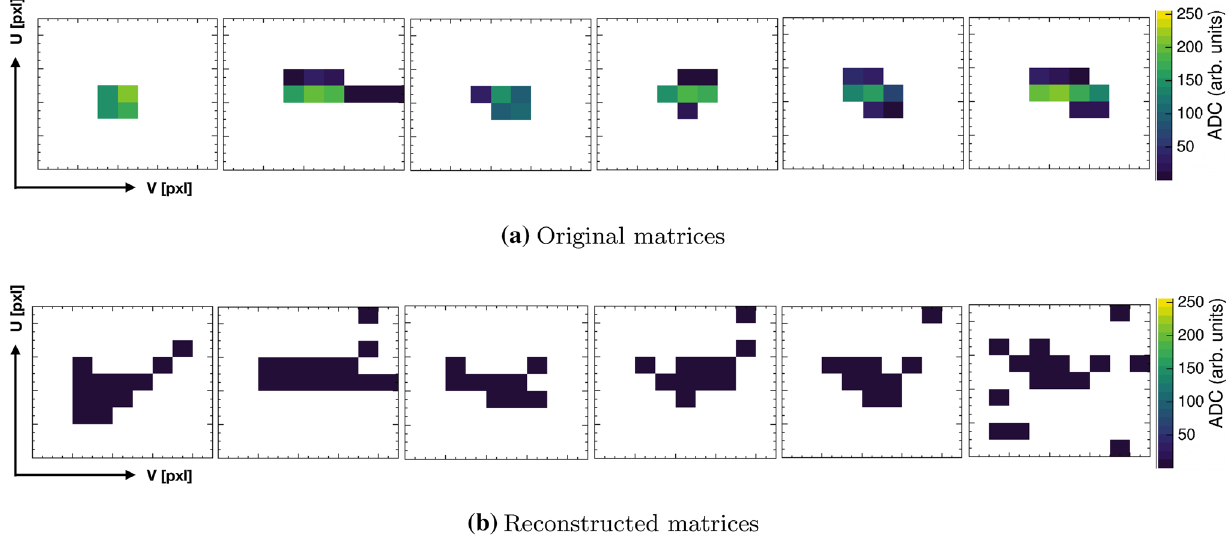
Fig. 8 a Input and b reconstructed pixel matrices associated with signal particles